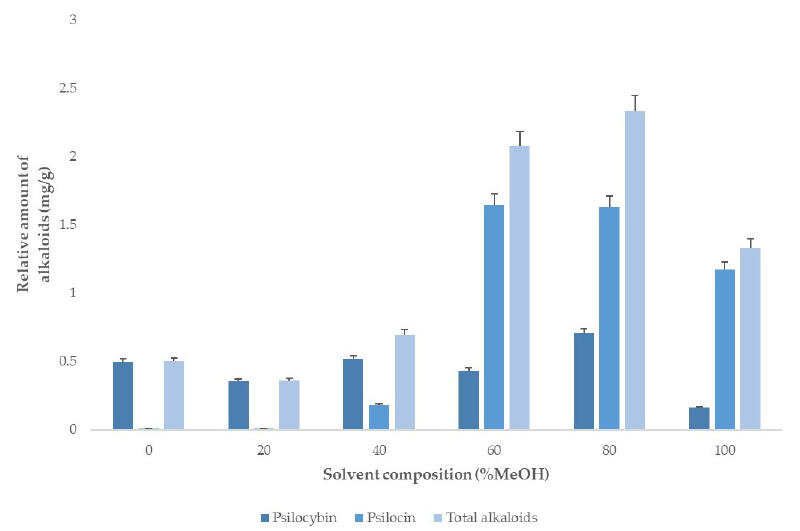
Figure 2. Alkaloids extraction yields obtained when using different methanol percentages in the solvent (water:methanol) ( n = 2).